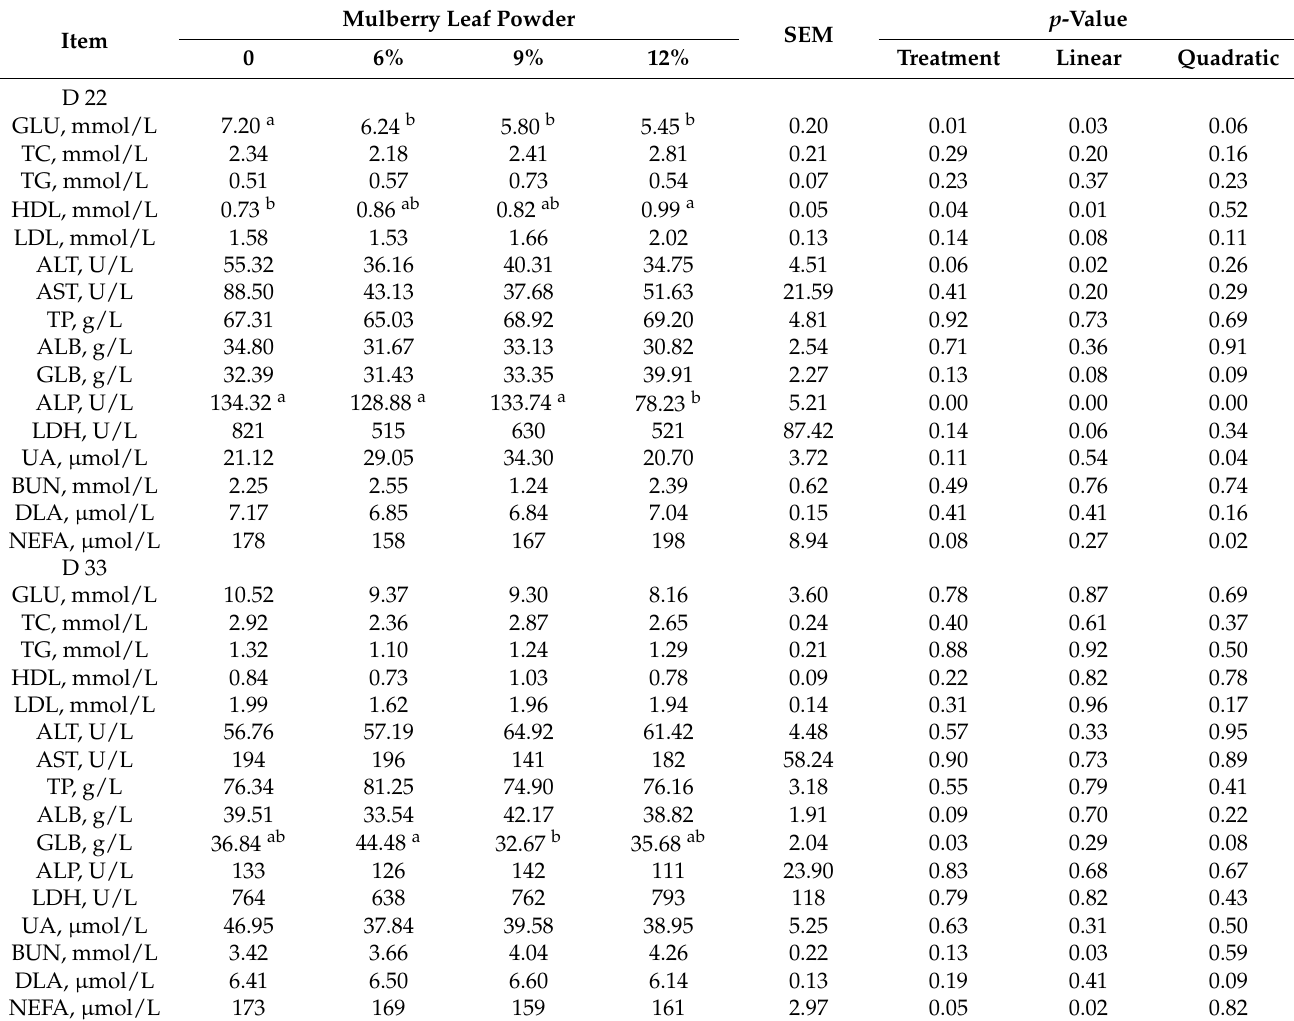
Table 3. Effect of mulberry leaf powder of varying levels on serum metabolite in finishing